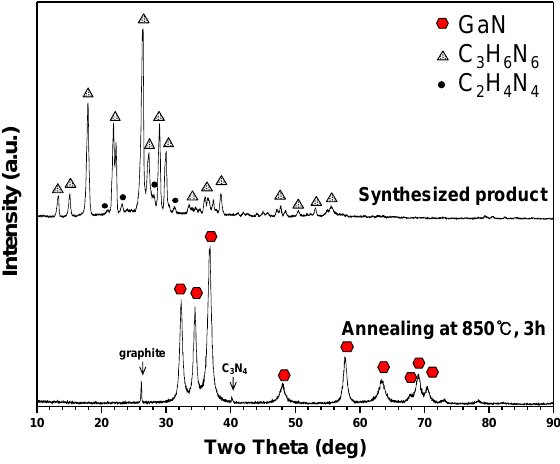
Figure 6. XRD patterns of products synthesized from a Ga(NO 3 ) 3 ∙32H 2 O pellet and C 3 H 6 N 6 powder injection with NH 3 gas by the thermal plasma process in Plasma 3.